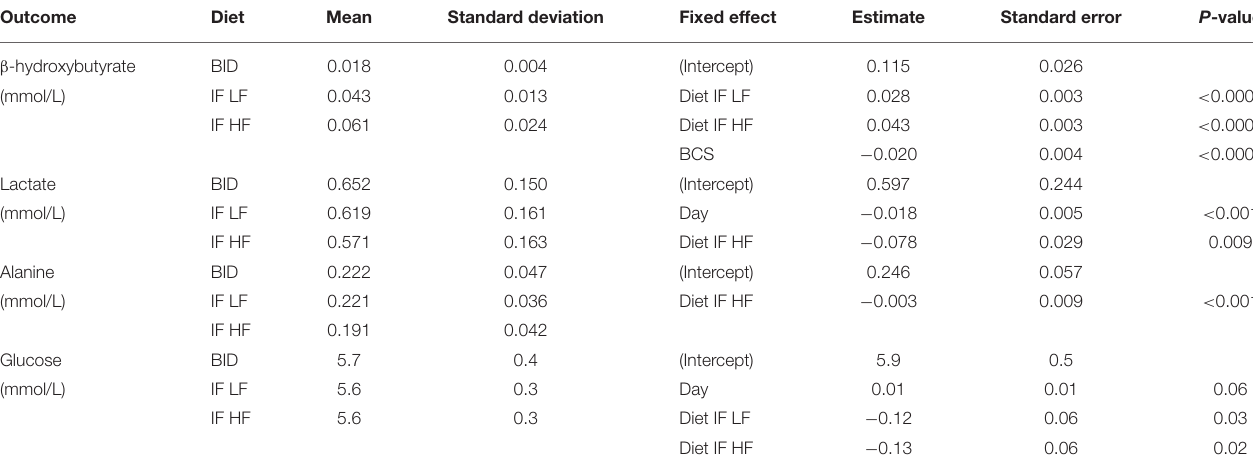
TABLE 3 | The means and standard deviations for β -hydroxybutyrate, lactate alanine and glucose, and the results of the linear mixed effect models, of 10 dogs fed daily (BID), and intermittently fasted on a low fat (IF LF) and a high fat diet (LF HF) in a Latin Square design. Outcome Diet Mean Standard deviation